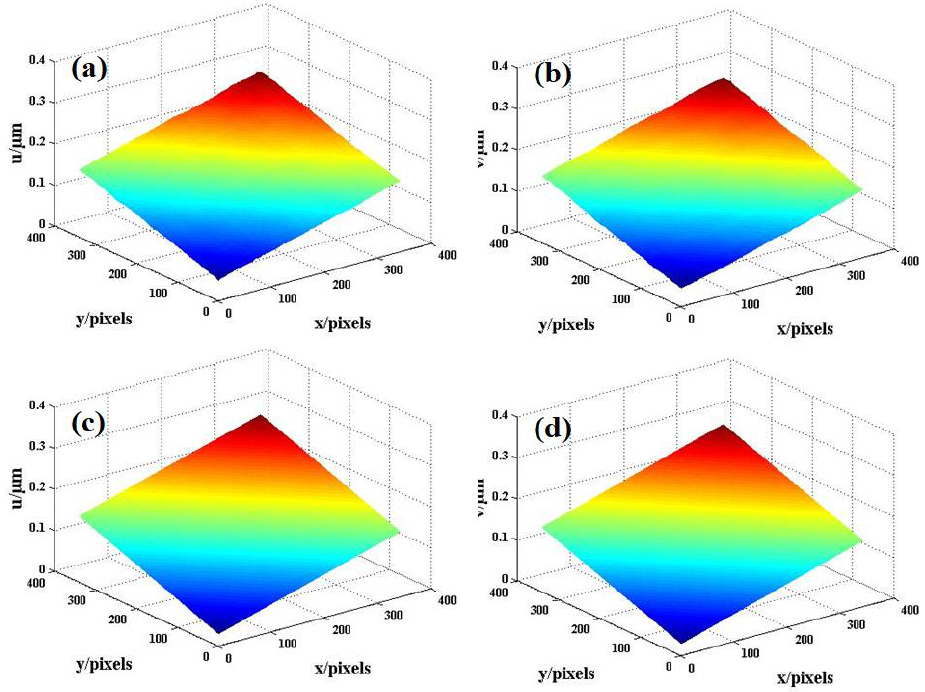
Figure 10. In-plane displacement results of application experiment: ( a ) field u (DIC method); ( b ) field v (DIC method); ( c ) field u (OF method); ( d ) field v (OF method).